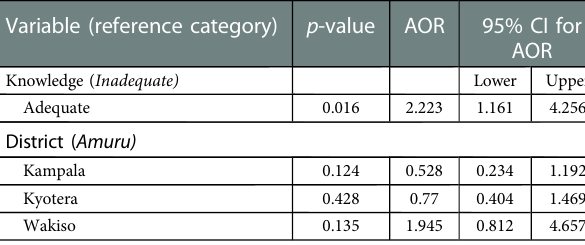
TABLE 7 Logistic regression results factors relating to attitude